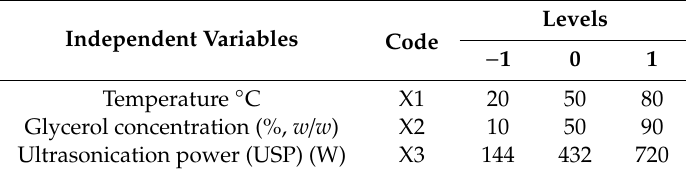
Table 1. Independent variables and their levels for Box–Behnken design. Independent Variables